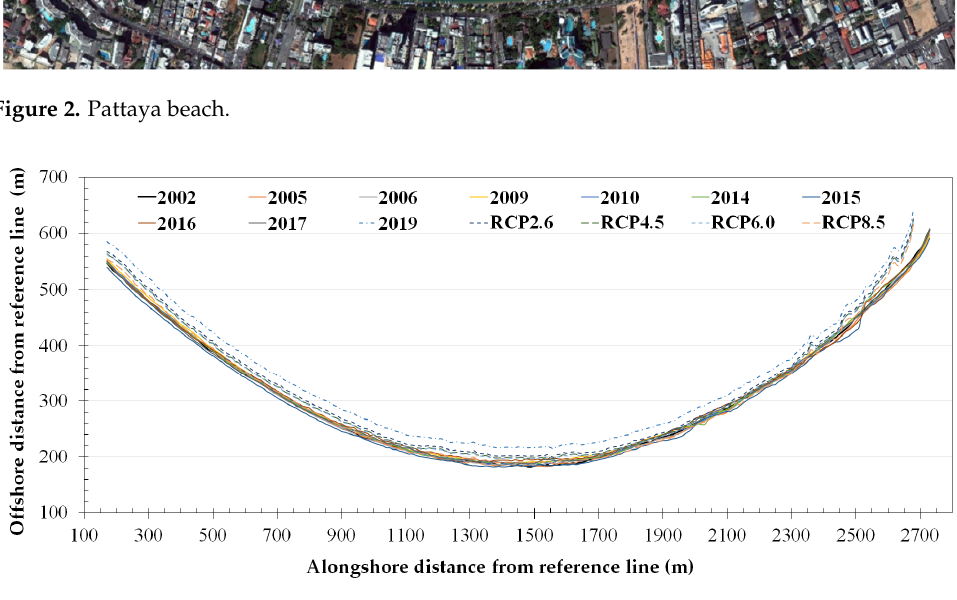
Figure 2. Pattaya beach.